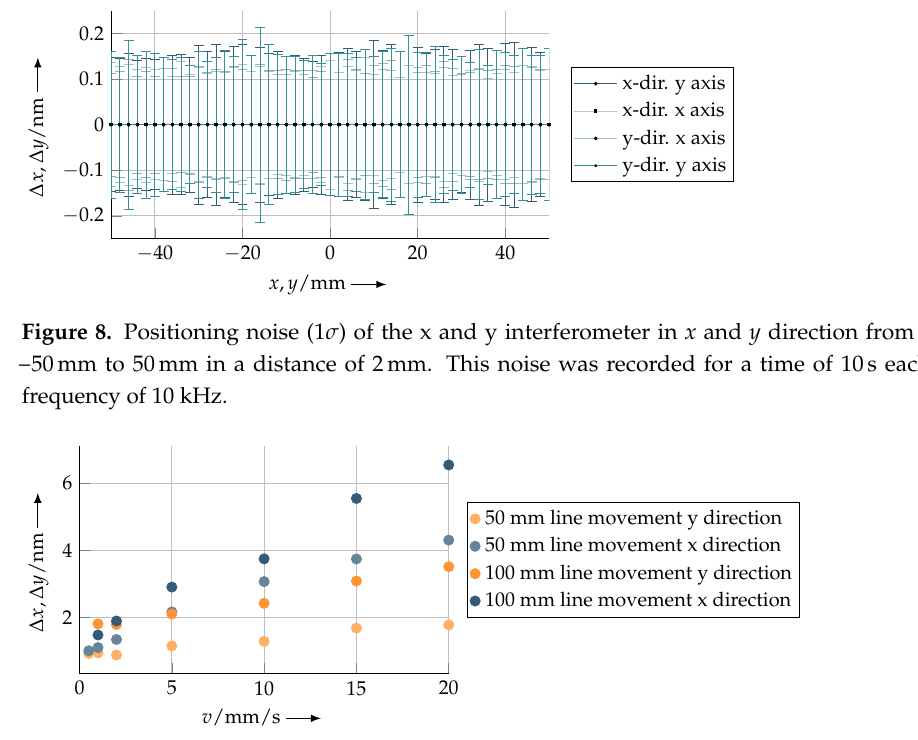
Figure 9. Straightness deviation for movements in x and y direction with a length of 50mm and 100mm. The dependence of the deviation of the line movement was investigated in a velocity range between 0.5mm/s and the maximum velocity of 20mm/s.